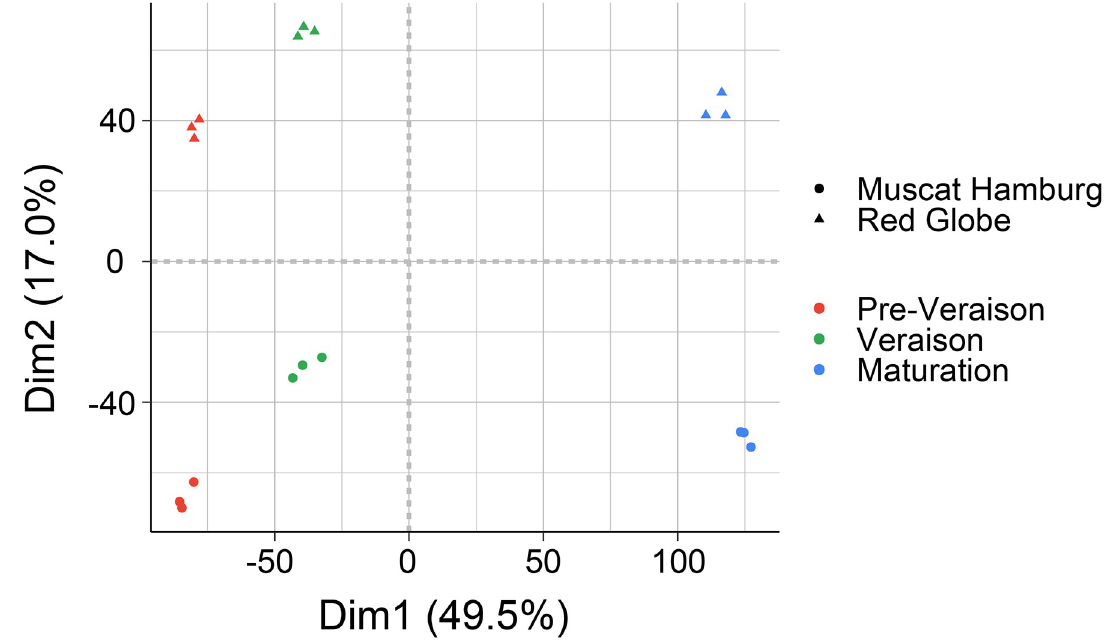
Fig 2. Principal component analysis of the RNA-Seq data. Circle and Triangle represent Muscat Hamburg and the Red Globe, respectively. The three different colors represent different development stages.